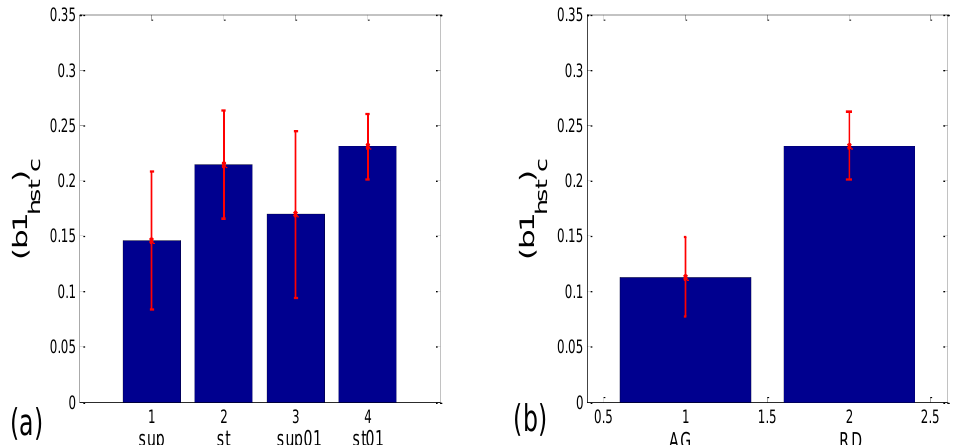
Figure 14. Group statistics of the circularly corrected histogram-derived standard deviation of b1 , denoted as ( b1 hst ) c , which is an inverse measure of b1 locking. Comparison of: ( a ) experimental states; ( b ) scatter plots with aggregation and the random distribution of ( BBI and mRRI ) points (AG and RD, respectively). Table 1. Summarized results of the statistical tests.